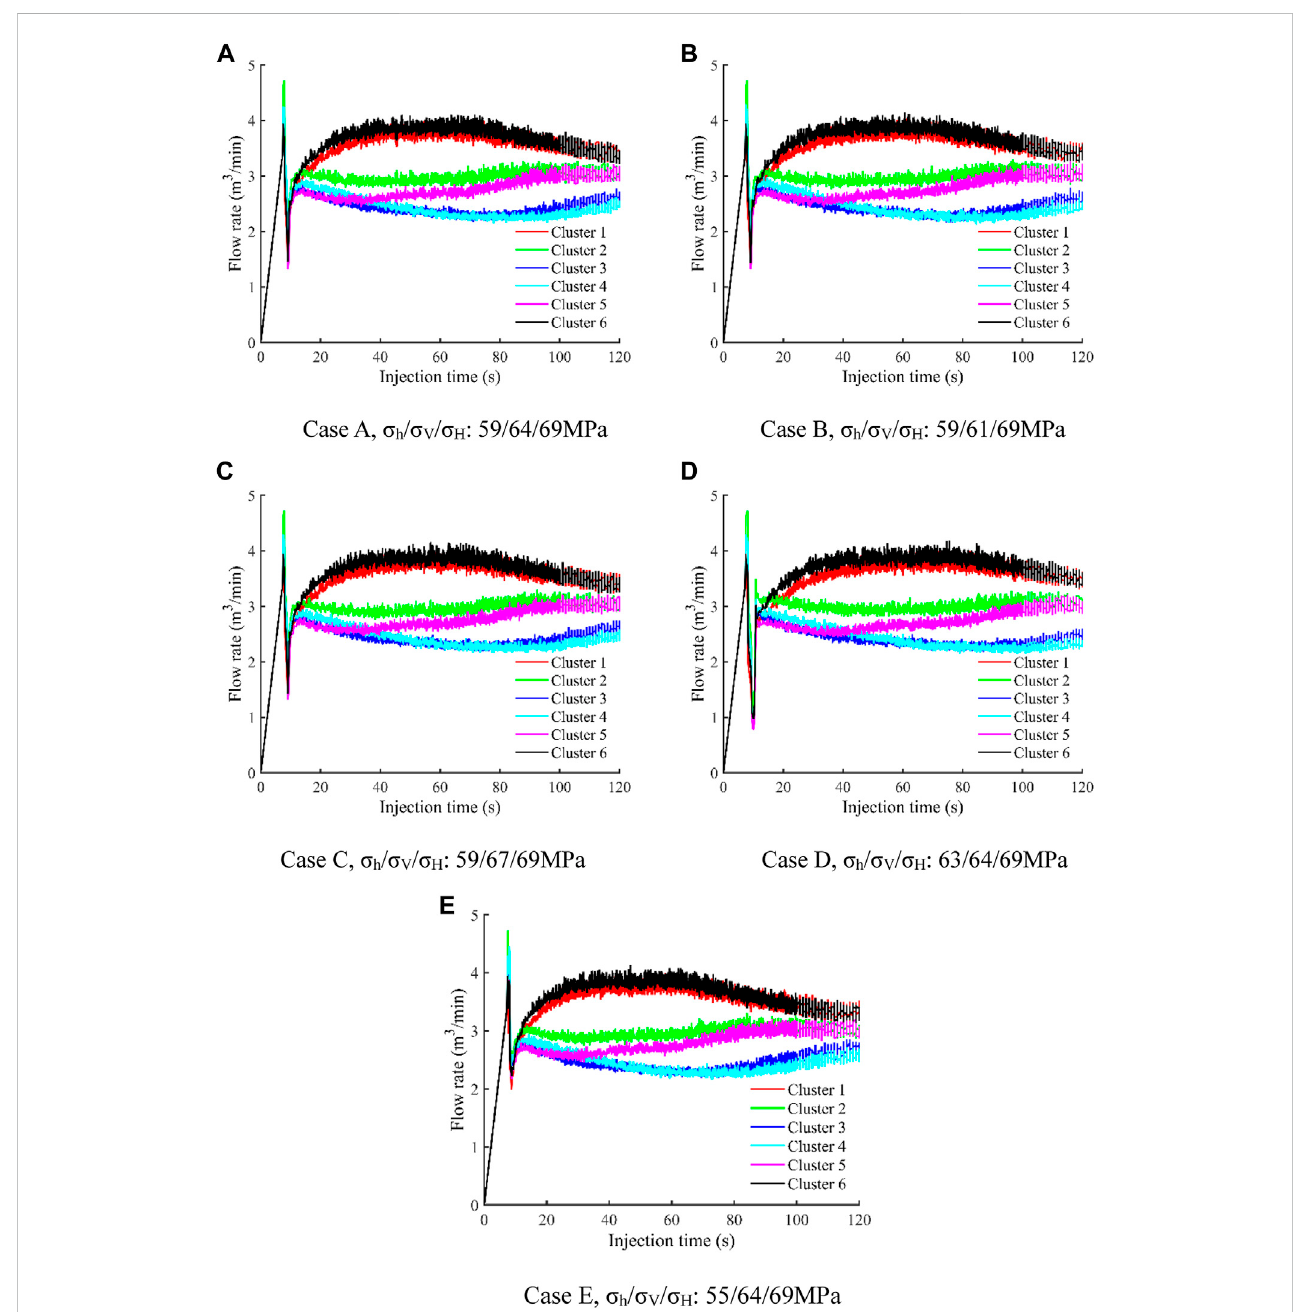
FIGURE 4 Flowrateintoeachclusterasafunctionoftimefor fi vecaseswithdifferent in-situ stresscombinationstates. (A) CaseA, σ h / σ V / σ H :59/64/69 MPa. (B) Case B,